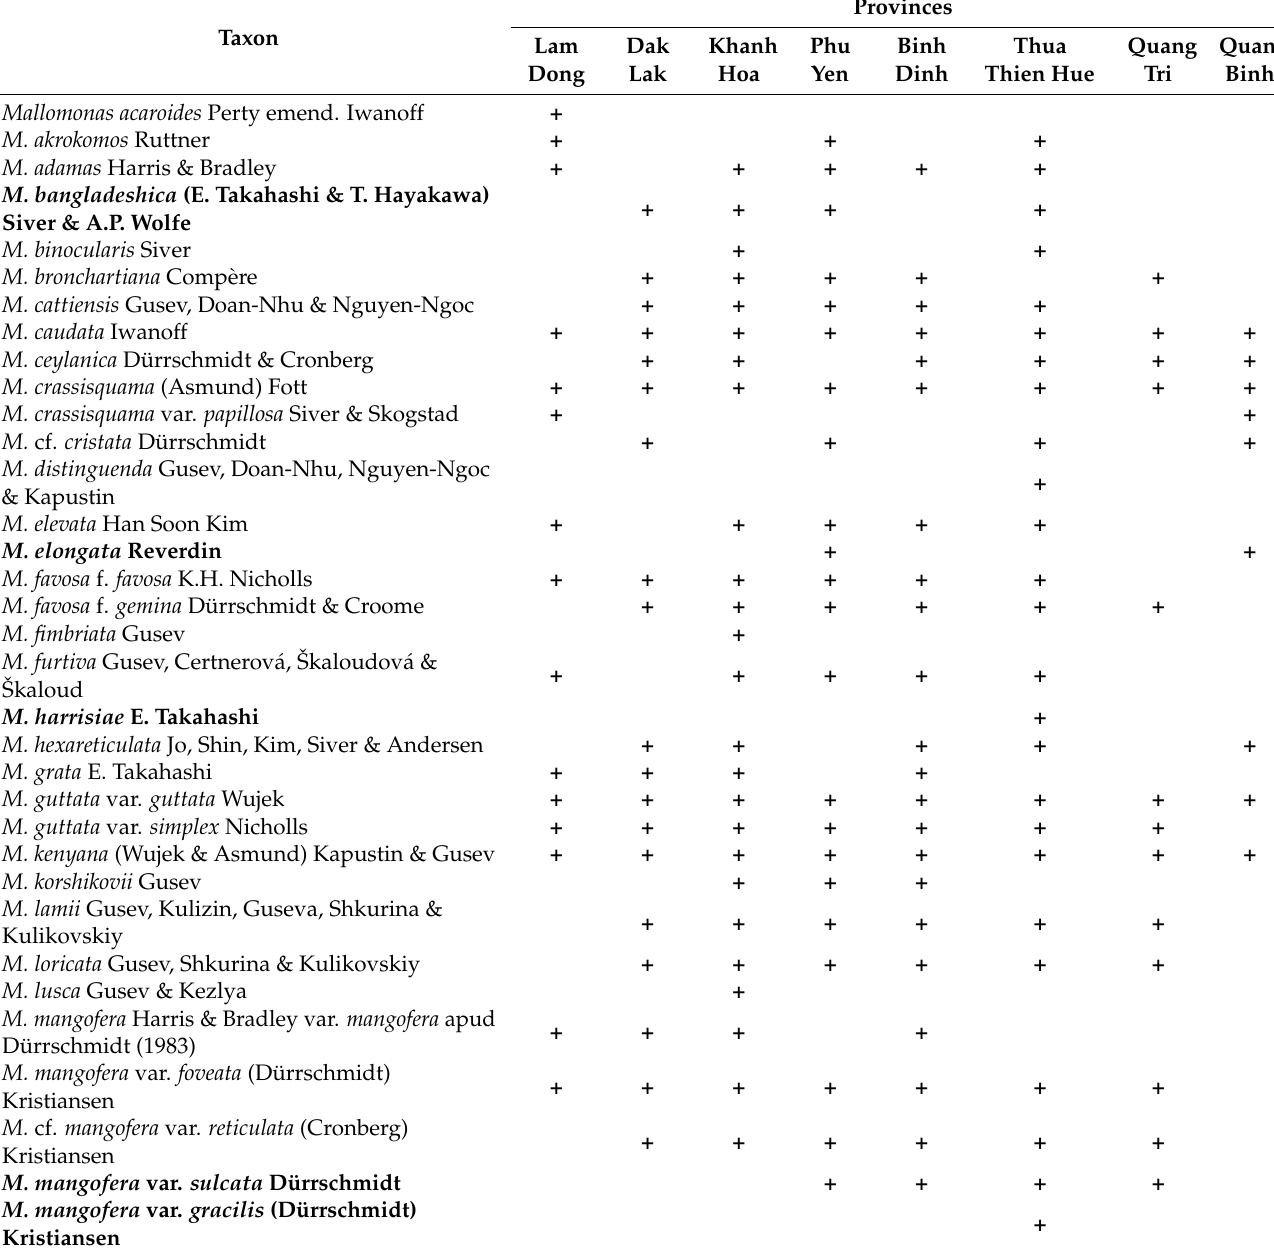
Table 1. List of silica-scaled chrysophytes found in eight provinces of Central Vietnam. New taxa for Vietnam are given in bold, “ + ” indicates the presence of